Question: Which kind of chart has been used to present this data?
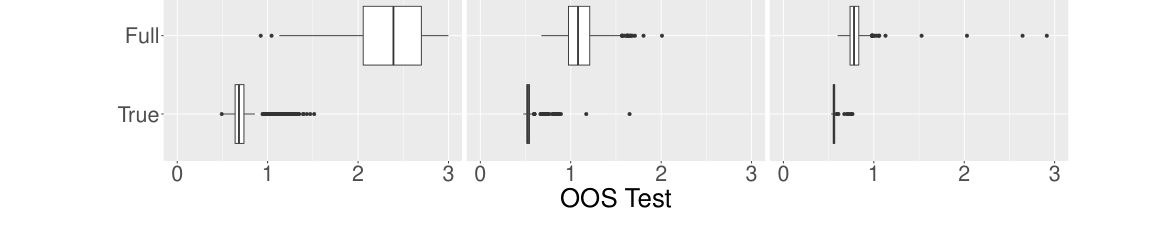
Answer: box